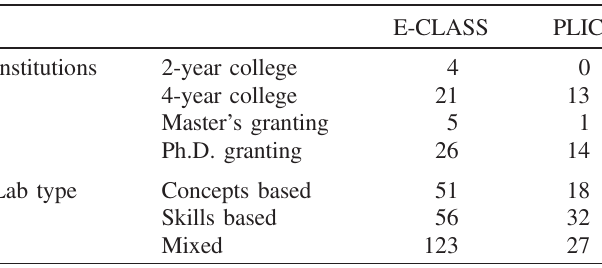
TABLE I. Breakdown of the institutions and classes included in the E-CLASS and PLIC